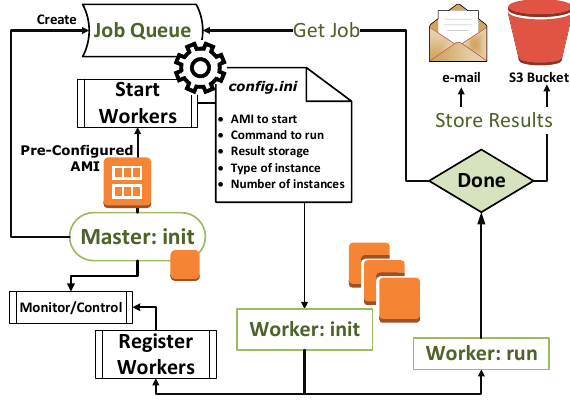
Figure 6. Maestro’s system design and